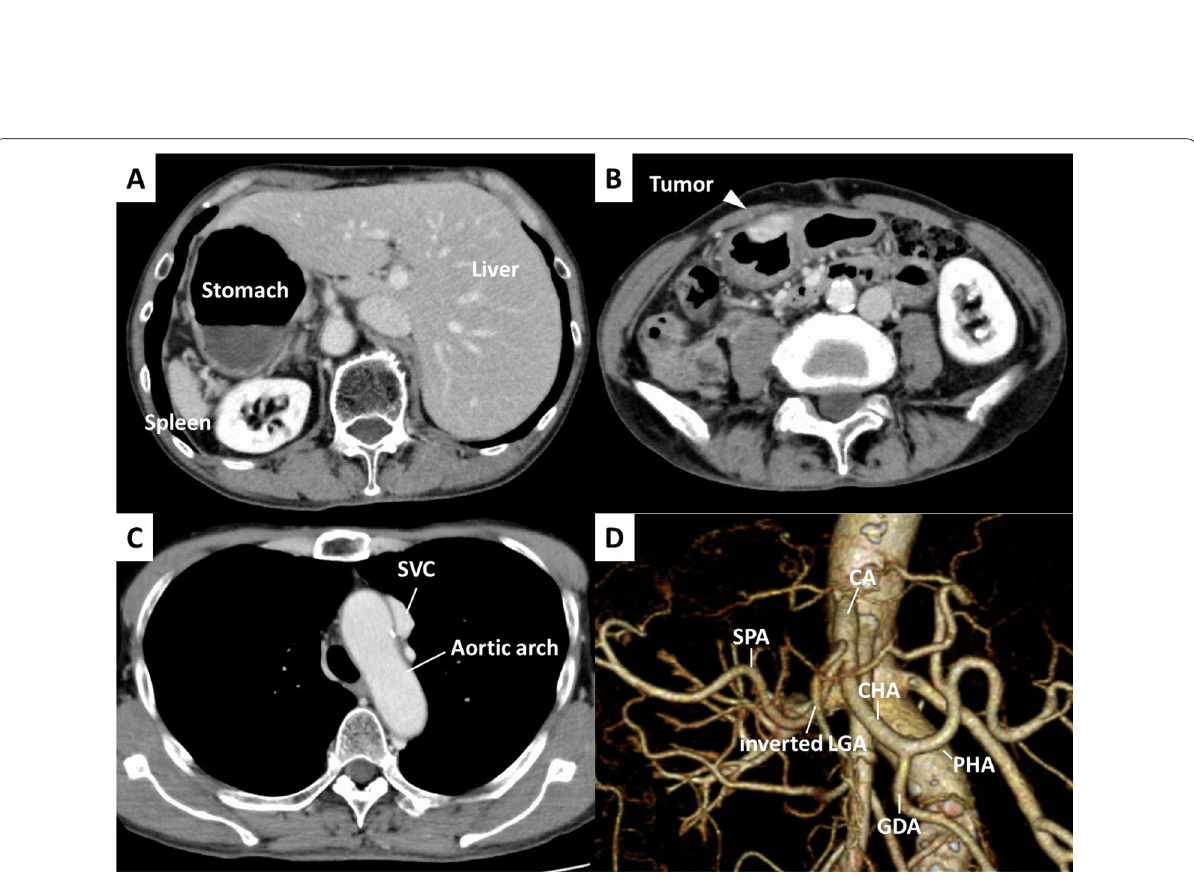
Fig. 2 A Contrast-enhanced MDCT revealed inverted abdominal organs B and illustrated the wall thickness of the stomach body (white arrowhead), which had no obvious metastasis. C The aortic arch to the thoracic aorta was in the normal position. D The 3D angiography showed a complete right–left reversal of the abdominal arteries. SVC superior vena cava, CA celiac artery, CHA common hepatic artery, PHA proper hepatic artery, GDA gastroduodenal artery, SPA splenic artery, LGA left gastric